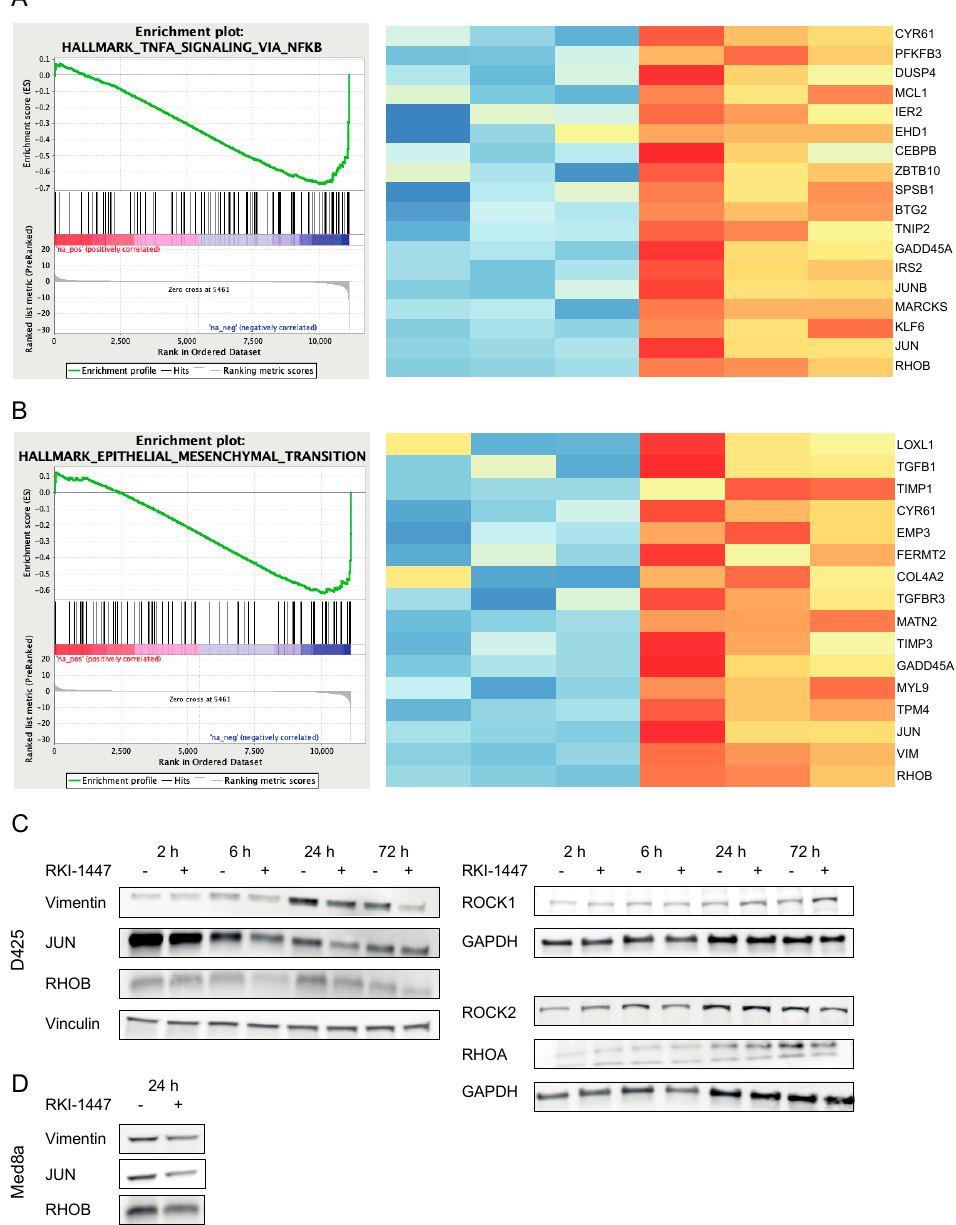
Figure 5. RKI-1447 downregulates TNF α via NF κβ and EMT signaling by inhibiting RHO, JUN, and vimentin. ( A , B ) GSEA of downregulated genes in RKI-1447 treated D425 cells (1 µ M for 24 h) demonstrated over-representation of genes related to TNF α signaling via NF κβ ( A ) and EMT ( B ). Left panel: Enrichment plot from GSEA software, gene set systematic name (MSigDB): M5930 and M5890. Right panel: Heatmaps of core enriched genes from the same gene sets, color labeled by deviation from the average across all samples. Red color = above average, blue color = below average. mRNA expression was assessed with RNA Seq. ( C , D ) Western blot analysis on RHOA (21 kDa), RHOB (21 kDa), JUN (40–50 kDa), vimentin (53 kDa), ROCK1 (160 kDa), ROCK2 (160 kDa) and loading control GAPDH (26 kDa) or vinculin (124 kDa) protein expression in D425 cells treated with 1 µ M RKI-1447 at di ff erent time points (indicated in the figure) ( C ) and RHOB (21 kDa), JUN (40–50 kDa), vimentin (53 kDa) and loading control vinculin (124 kDa) protein expression in Med8a cells treated with 1 µ M RKI-1447 for 24 h ( D ). For densitometric analyses see Figure S6.